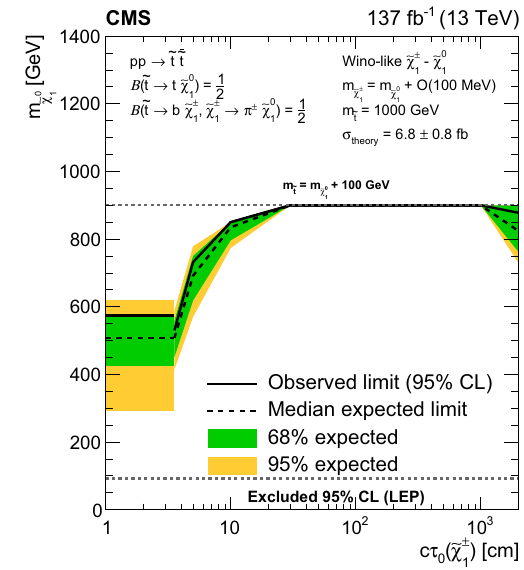
= Fig. 21 Exclusion limits at 95% CL on the ˜ χ 0 mass, with m ˜ χ ± 1 1 + O ( 100 MeV ) , as a function of the ˜ χ ± m ˜ χ 0 proper decay length, 1 1 for direct top squark pair production, as obtained for a representative top squark mass. The area enclosed by the solid (dashed) black curve represents the observed (median expected) exclusion region, while the inner green (outer yellow) band indicates the region containing 68 (95)% of the distribution of limits expected under the background- only hypothesis. At short decay lengths, horizontal exclusion lines are obtained from the inclusive M T2 search, as this is not affected by track reconstruction inefficiencies, which may arise when the ˜ χ ± decays 1 before the CMS tracker, and therefore shows better sensitivity to sce- ) compared to the disappearing track narios with very small c τ 0 ( ˜ χ ± 1 search, based on median expected limits. The horizontal dashed line = m + 100 GeV indicates the minimum simulated mass dif- at m ˜ ˜ χ 0 t 1 , chosen such that the decay of top ference between top squark and ˜ χ 0 1 quarks to on-shell W bosons is allowed. If all kinematically allowed ˜ χ 0 ≤ m ˜ − 100 GeV) are excluded, the curves, including masses ( m ˜ χ 0 t 1 1 68 and 95% expected, tend to overlap. The band at masses of the ˜ χ 0 1 below 91.9 GeV represents the region of the mass plane excluded at the CERN LEP [151]. Signal cross sections are calculated at approximately NNLO+NNLL order in α S [136–147], assuming decay branching frac- tions ( B ) as indicated in the